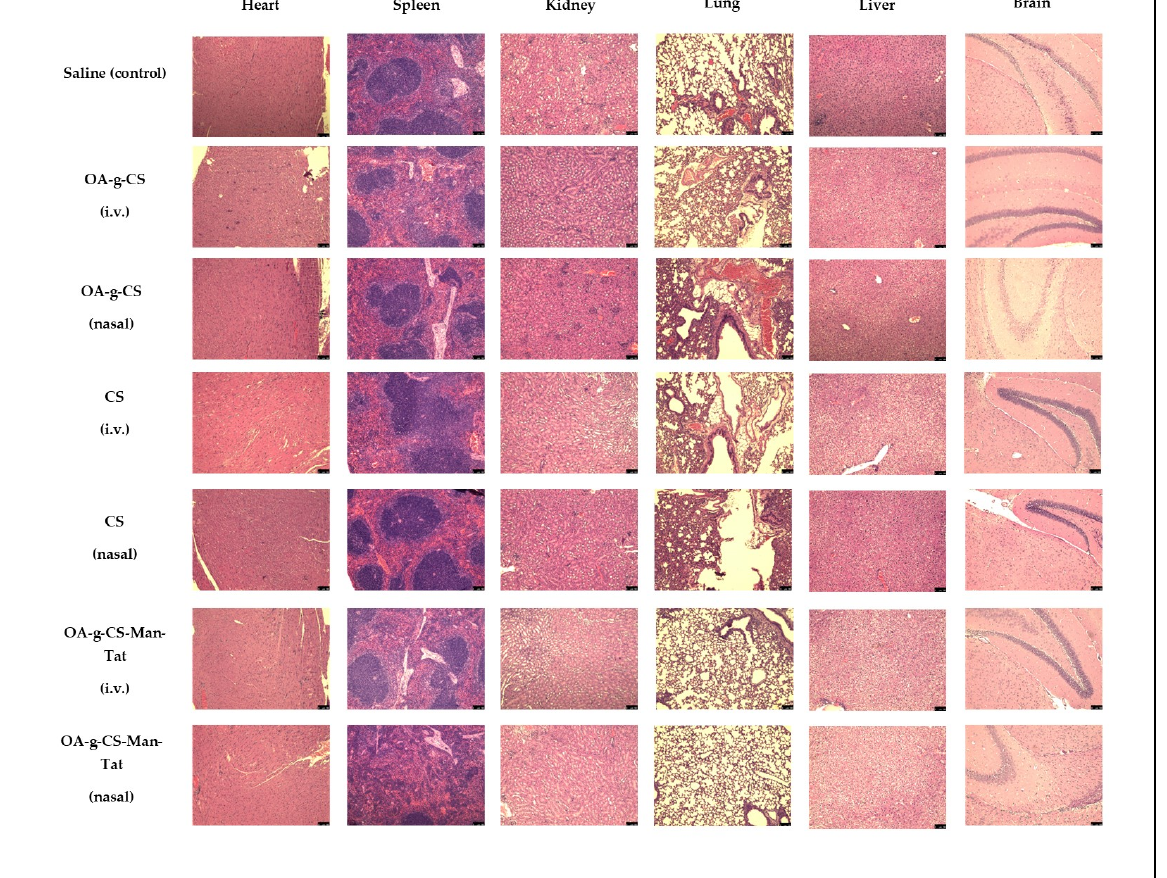
Figure 11. H and E staining of heart, spleen, kidney, lung, liver, and brain, showing no toxicity from different groups after drug administration. Images were taken at 20× magnification and the scale bar is 75 µm.